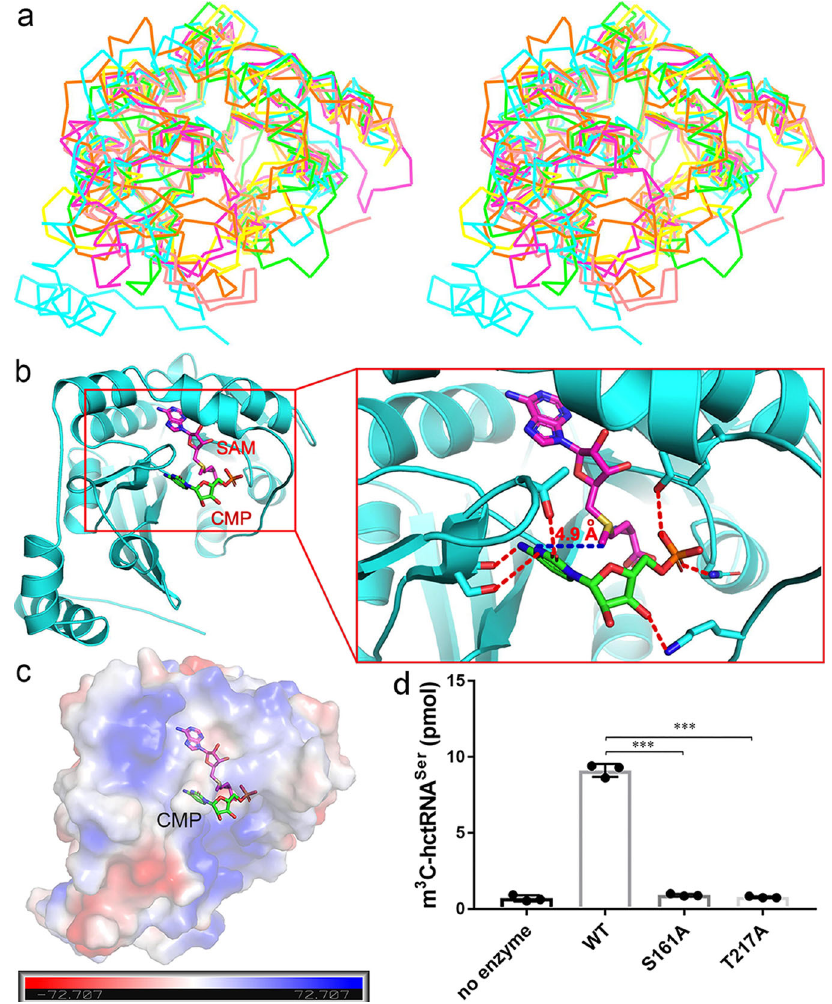
Fig. 5 The structural superposition and possible CMP binding mode. a structural superimposition of the backbone structure of hMETTL6 (PDB 7EZG, colored cyan) onto that of SAM-dependent methyltransferase cg3271 from Corynebacterium glutamicum (PDB 3H2B, green), SAM-dependent methyltransferases q8puk2_metma from Methanosarcina mazei (PDB 3SM3, magenta), methyl transferase from Methanosarcina acetivorans (PDB 6MRO, yellow), SAM-dependent methyltransferase (np_349143.1) from Clostridium acetobutylicum (PDB 2P8J, pink), and Burkholderia thailandensis